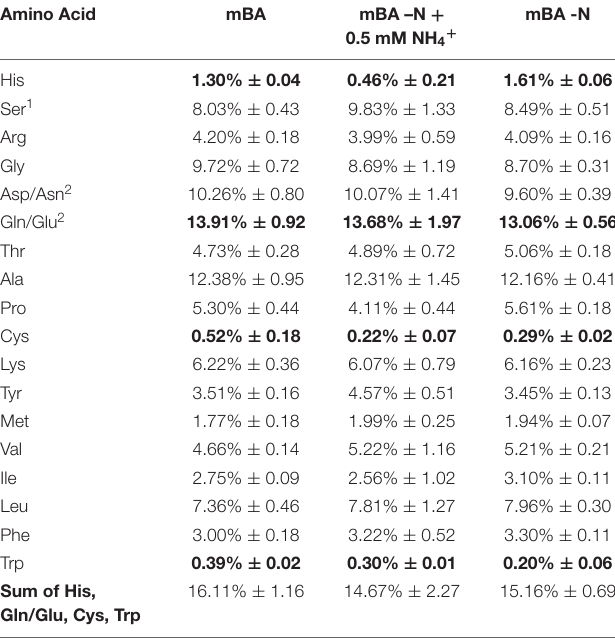
TABLE 3 | Amino acid content of D.